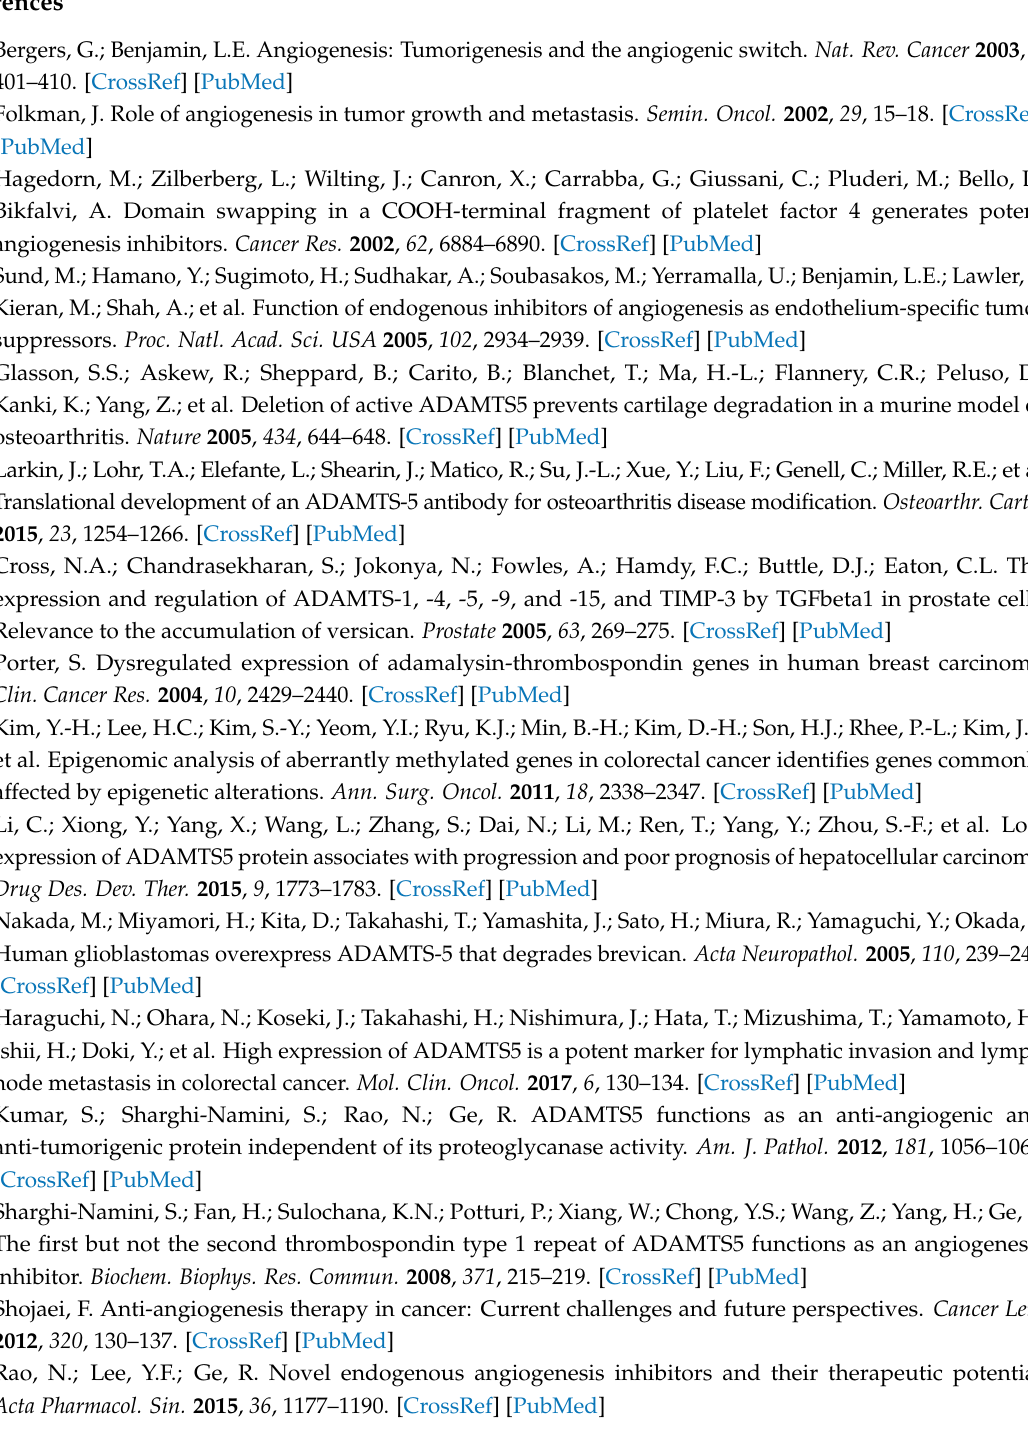
Figure S1: rTSR1 did not induce apoptosis in B16 melanoma